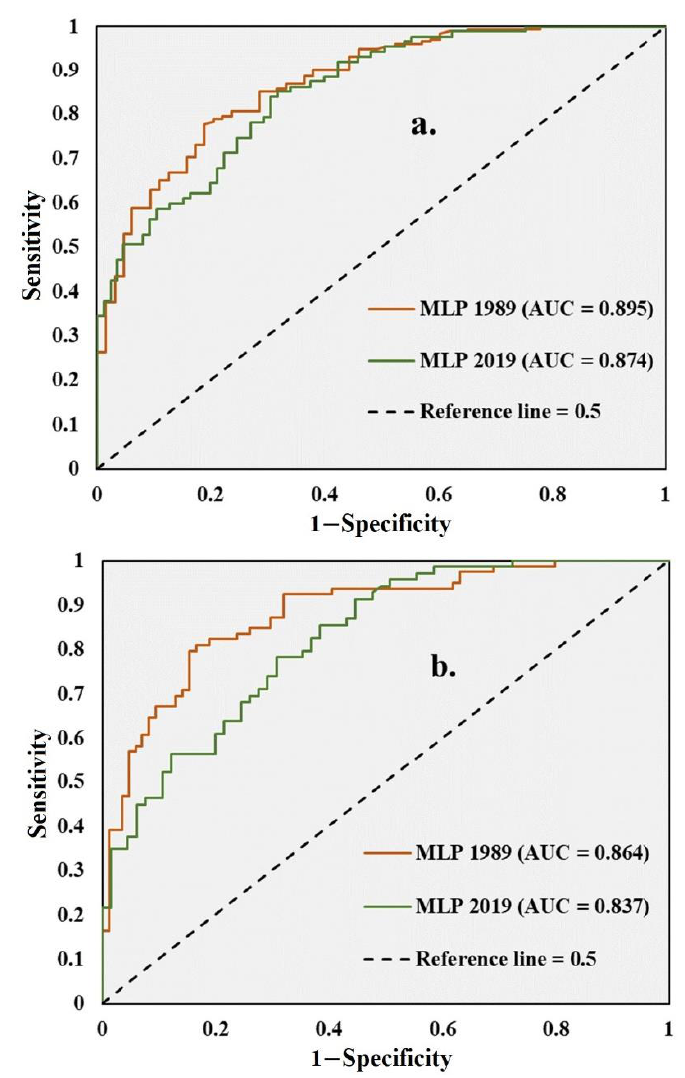
Figure 9. ROC Curve: ( a ) success rate and ( b ) prediction rate.